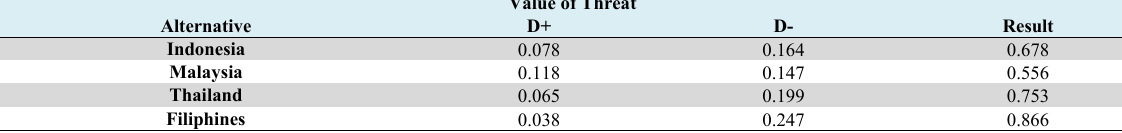
Value of Threat